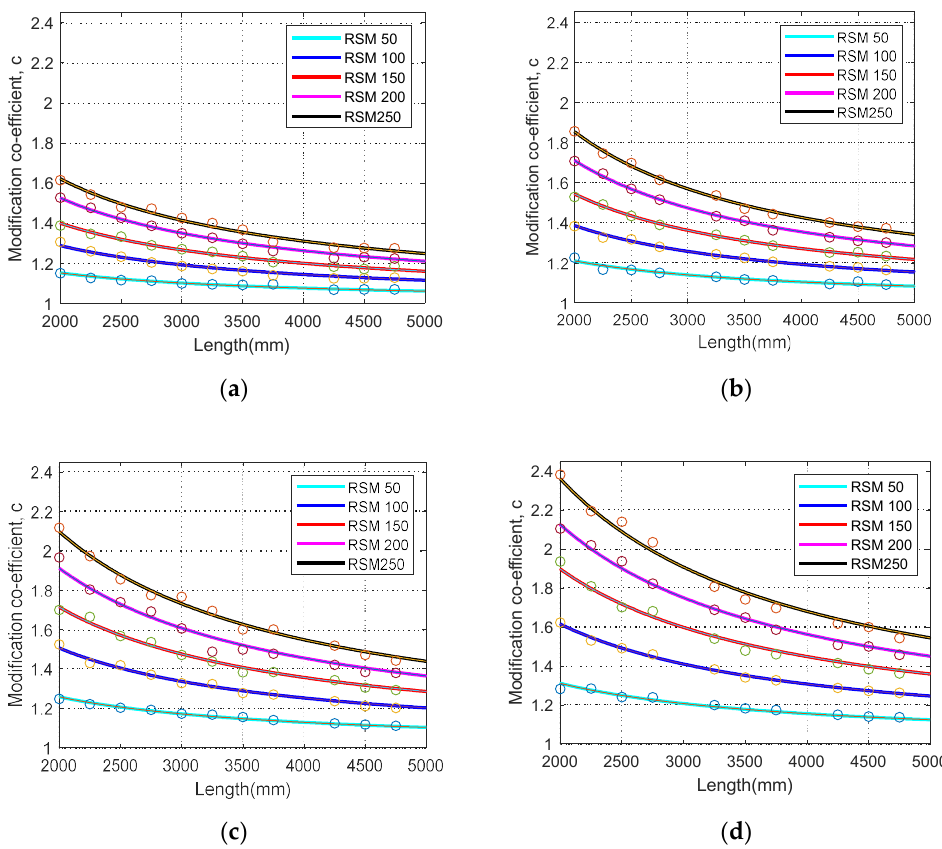
Figure 15. Modification co-efficient against length. ( a ) 90 mm thick CLT panels, ( b ) 120 mm thick CLT panels, ( c ) 150 mm thick CLT panels and ( d ) 180 mm thick CLT panels.